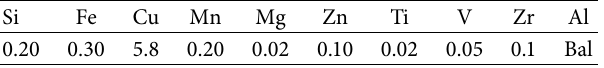
Table 1: Chemical composition of AA2219 (wt.